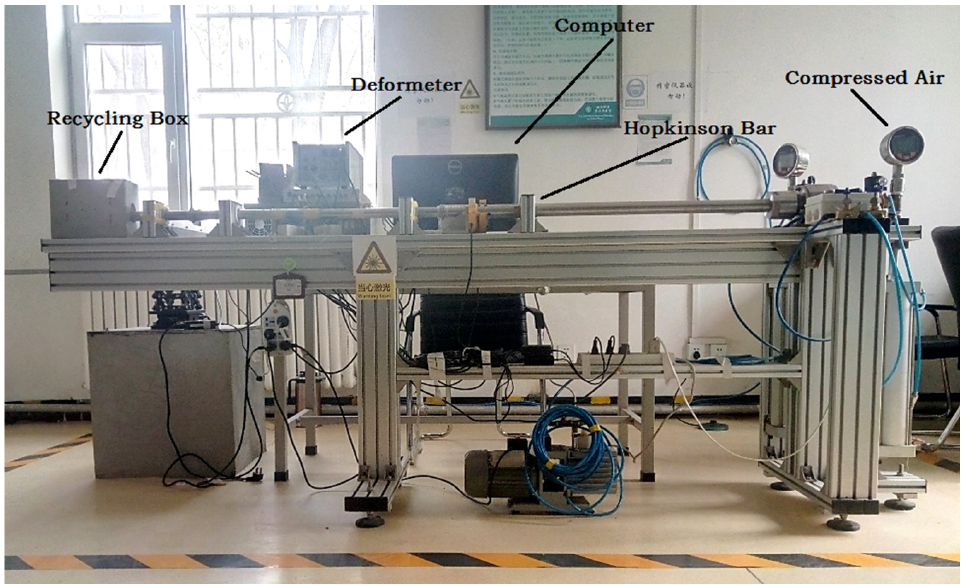
Figure 11. Hopkinson Bar calibration system.